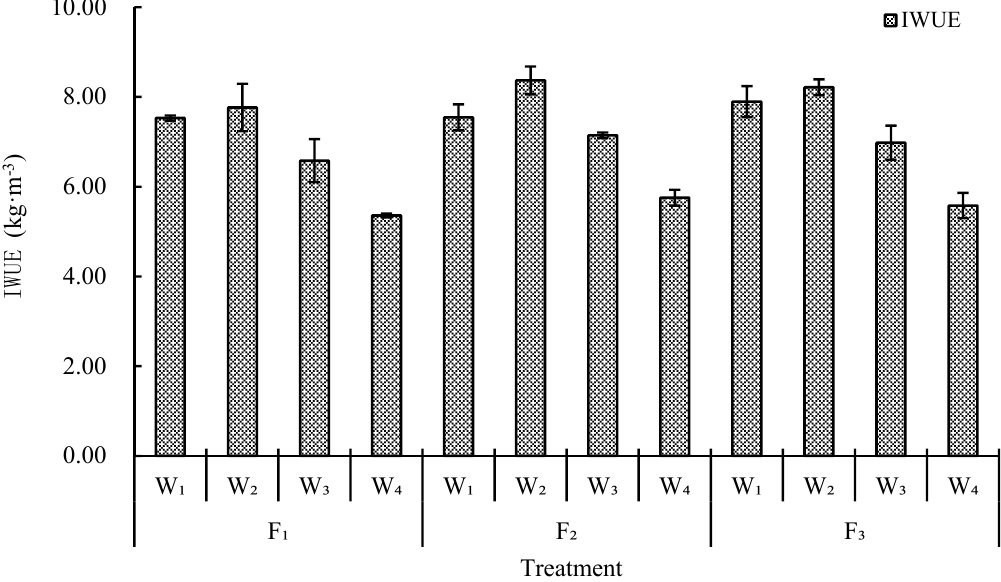
Figure 7. Effects of different water and fertilizer treatments on irrigation water use efficiency (IWUE) of young apple trees in 2013. The effect of irrigation on IWUE was very significant in 2013 ( p < 0.01), but it was not significant for fertilizer and the interaction of water and fertilizer ( p > 0.05). Irrigation, fertilizer and the interaction with water had a very significant impact on PFP in 2013 ( p < 0.01) (Figure 8). When fertilizer levels were fixed, the increase of irrigation amount significantly and 123.9% higher than that in W 2 , W 3 and W 4 , respectively. When the irrigation amount was